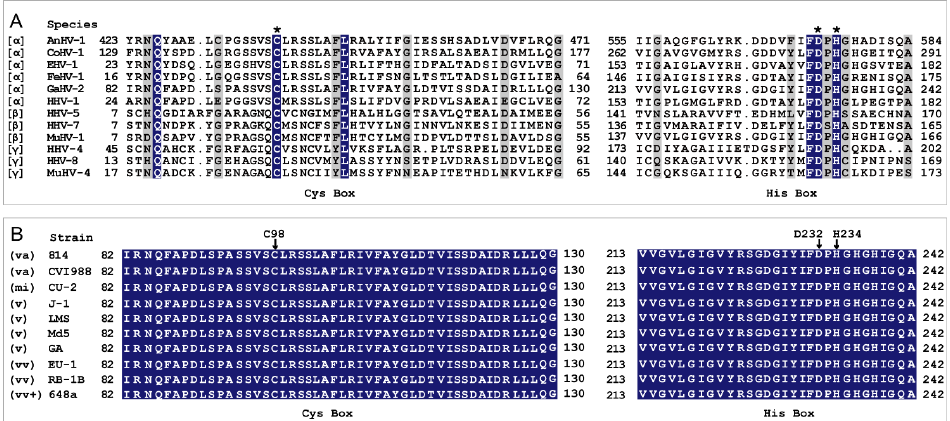
Figure 1. The amino acid sequence alignment between the deubiquitinases (DUBs) encoded by different viruses of Herpesviridae . (A) Alignment between the DUBs encoded by different species of Herpesviridae . (B) Alignment between the DUBs encoded by different strains of Mardivirus . Asterisks (*) indicate the predicted catalytic triad of viral DUBs. Arrows point to mutation sites. Greek alphabet in square brackets in (A) refers to the subfamily of viruses. The abbreviation in parenthesis in (B) refers to the virulence of MDV, and va = vaccine; mi = mild; v = virulent; vv =very virulent; vv+ = very virulent plus. (The accession numbers of viral DUBs are given in Tables S2 and S3).